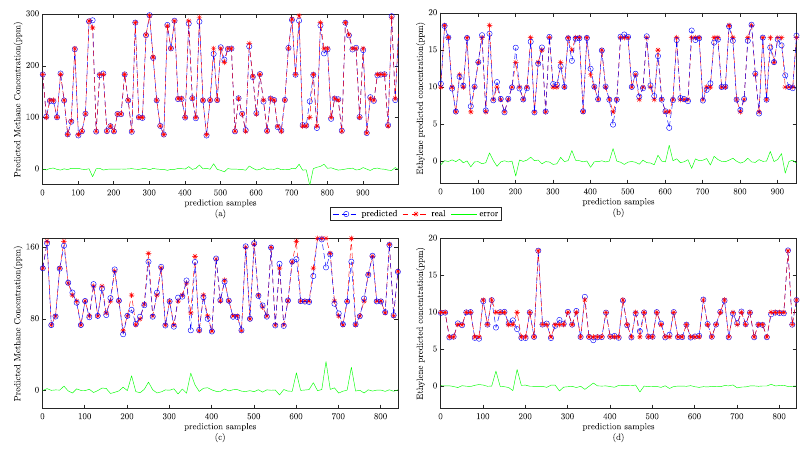
Figure 6. The SSA-SVR gas-concentration prediction results. ( a ) The predicted concentration of methane under a single gas; ( b ) the predicted concentration of ethylene under a single gas; ( c ) the predicted concentration of methane under the mixed gas; and ( d ) the predicted concentration of ethylene in the mixed